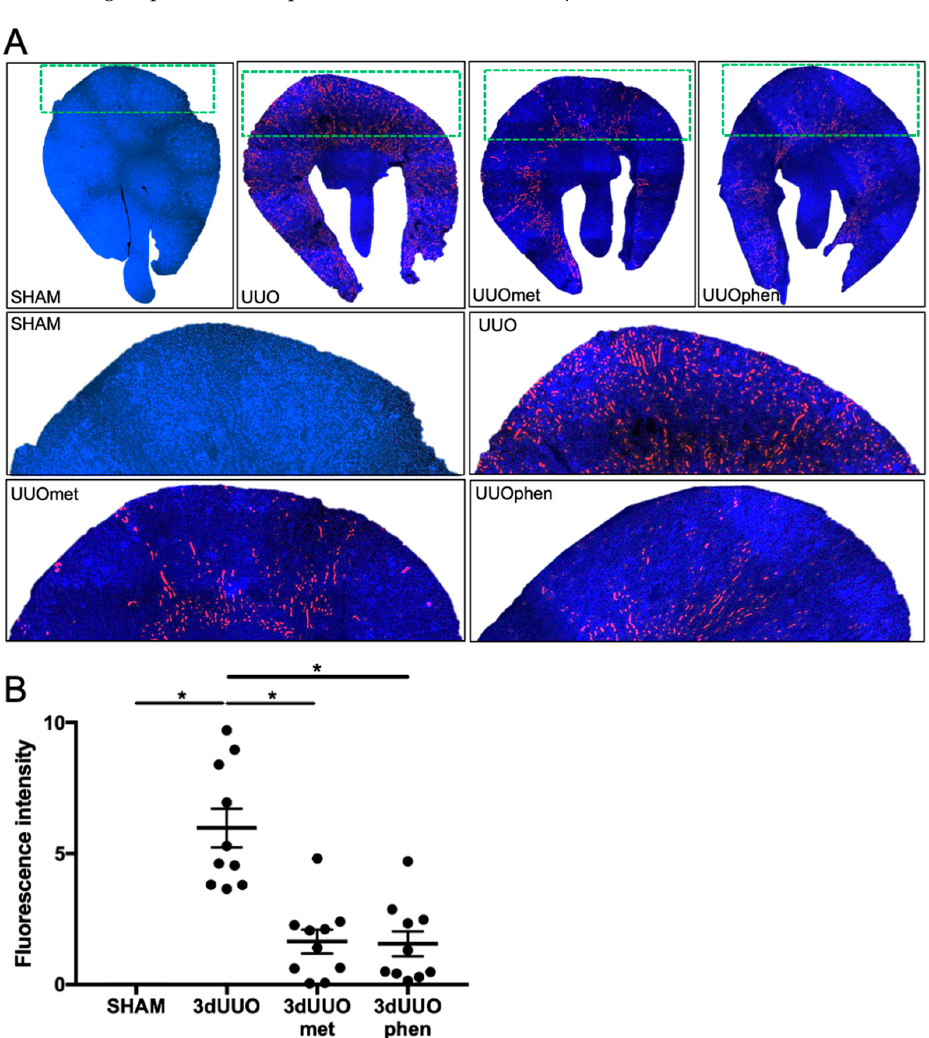
Figure 2. Protein expression of KIM-1 following UUO and biguanide treatment. ( A ) Whole kidneys and enlarged take-outs stained for KIM-1 (red) and nuclei (blue). 10 pictures were captured for each kidney in order to cover the whole cortex, n = 4 for each group. ( B ) Quantification of KIM-1 staining. Each bar represents the mean ± SEM. * p < 0.05.